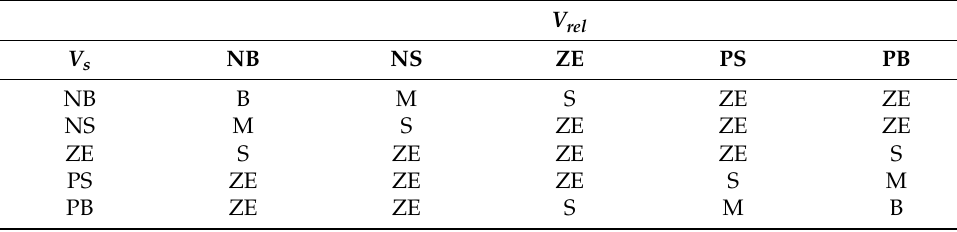
Table 3. Rules of the fuzzy